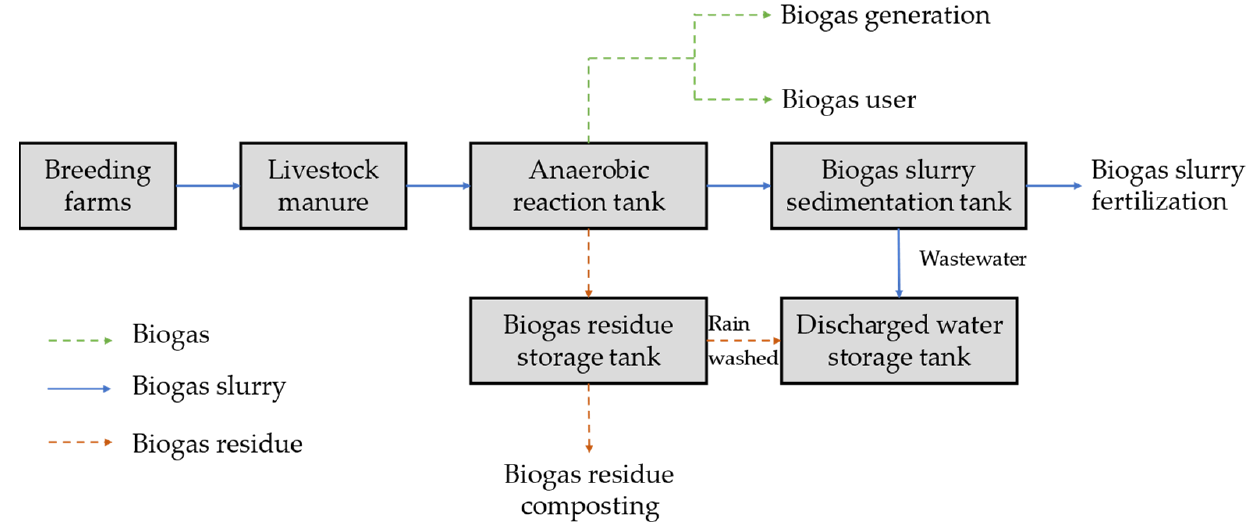
Figure 2. The manure treatment mode of the selected farms in Jiangsu Province, in the Yangtze River Basin.